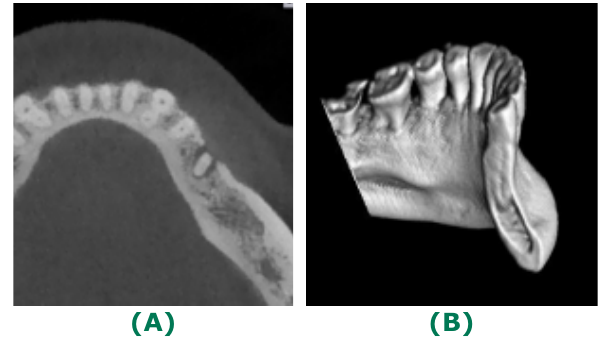
Figure-I: CBCT showing permanent mandibular canine with two Table-I: Stratification of number of roots in mandibular canine with gender. No. of Roots of